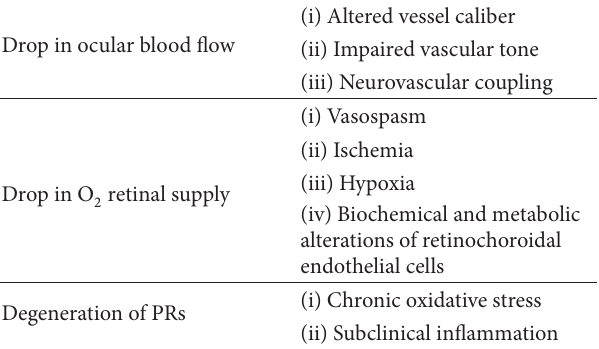
Table 1: The local and systemic increase of ET-1 and the vascular dysregulation syndrome in